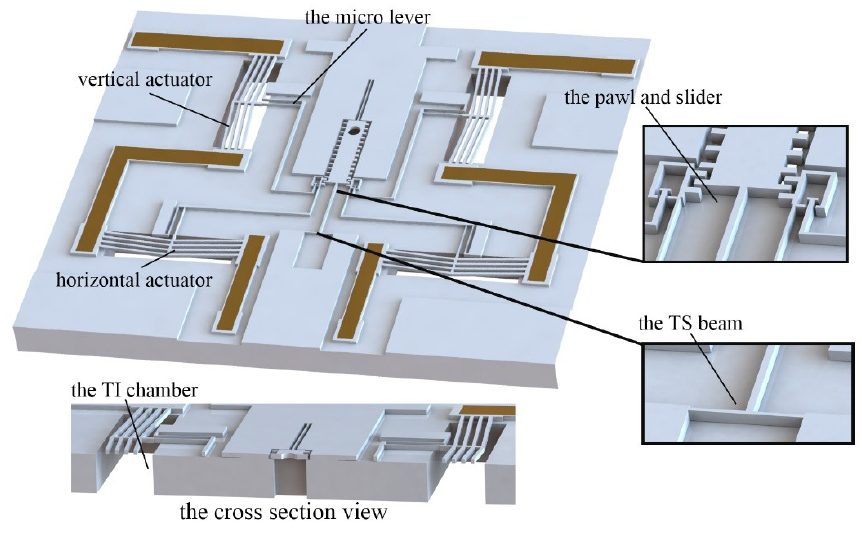
Figure 5. The structure of the actuation chip.